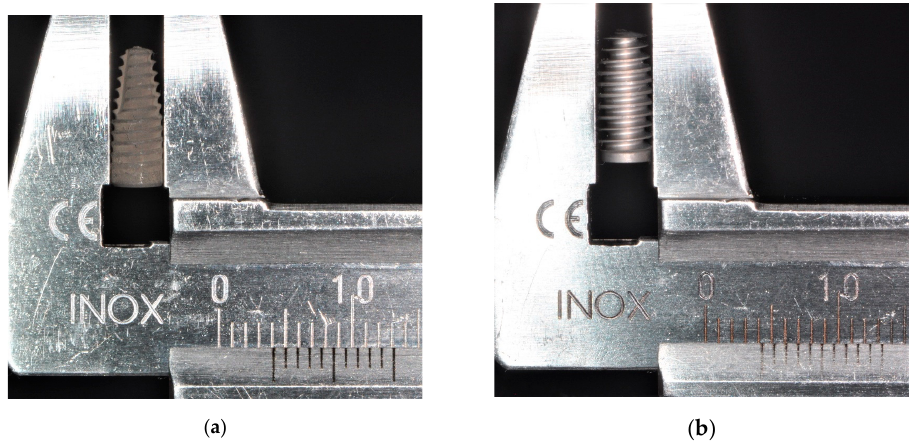
Figure 1. Bone-level implant types used in this study comprising Straumann BLT 4.1 × 10 mm ( a ) and AlfaGate 4.3 × 10 mm ( b ).